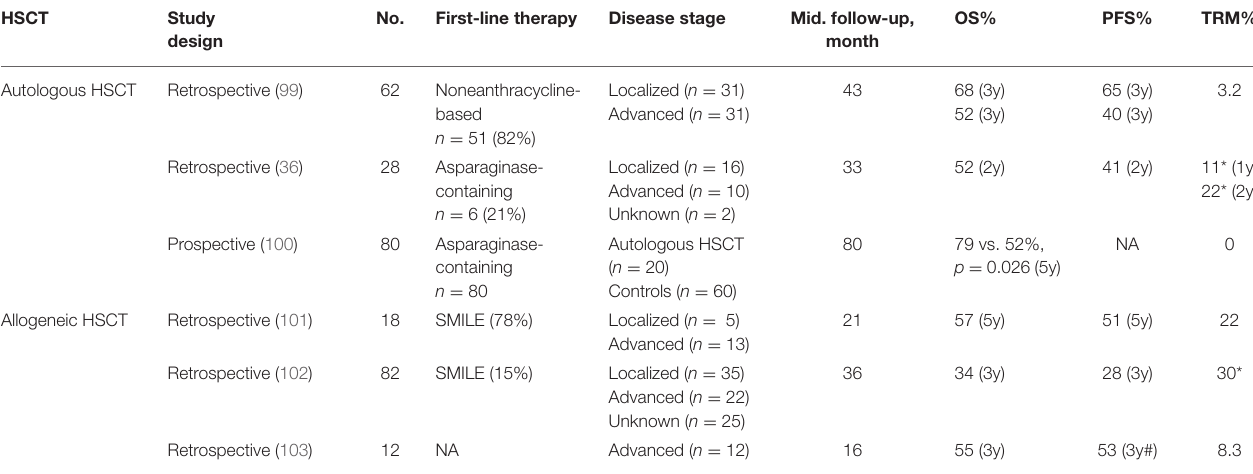
TABLE 3 | Selected studies of autologous and allogeneic HSCT for ENKL patients.